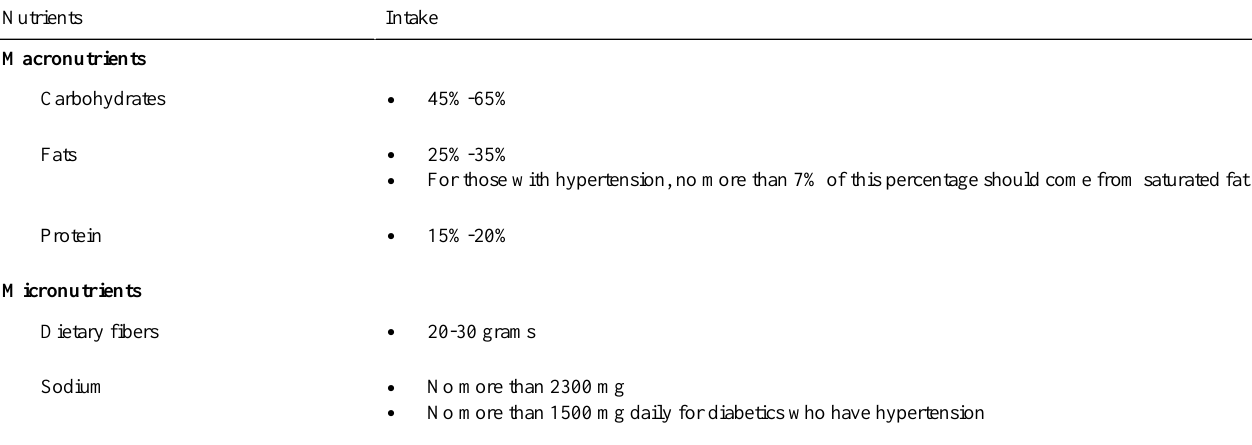
Table 1. The nutrition limits per daily recommended percentages/amounts of total calorie